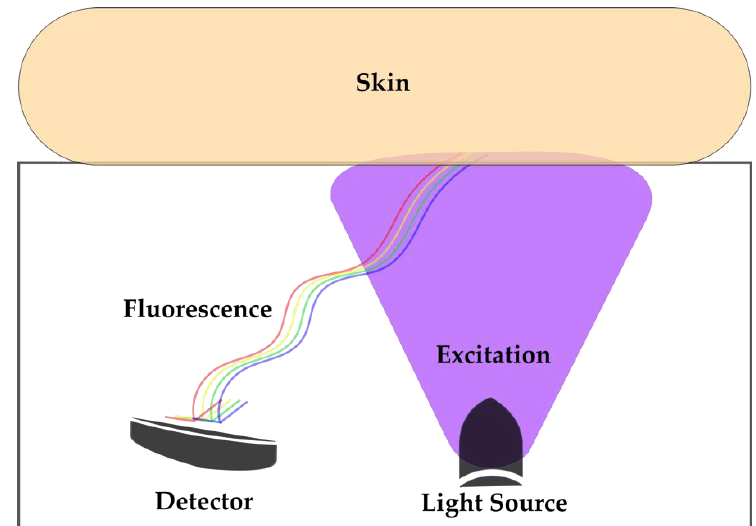
Figure 2. Schematic of skin autofluorescence. Upon blue light excitation of the skin, fluorescence of a wide spectrum is emitted by advanced glycation end products (AGEs) and detected by an autofluorescence (AF) device, e.g., the AGE Reader. The AGE fluorescence intensity positively correlates with the cardiovascular risk.